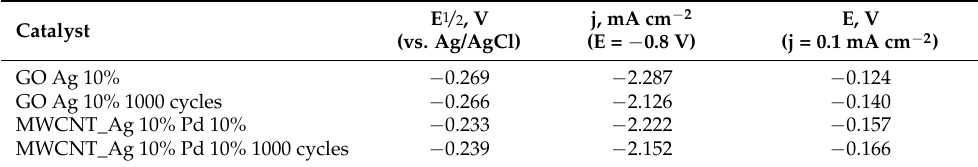
Table 4. Characteristics of catalysts before and after corrosion testing.